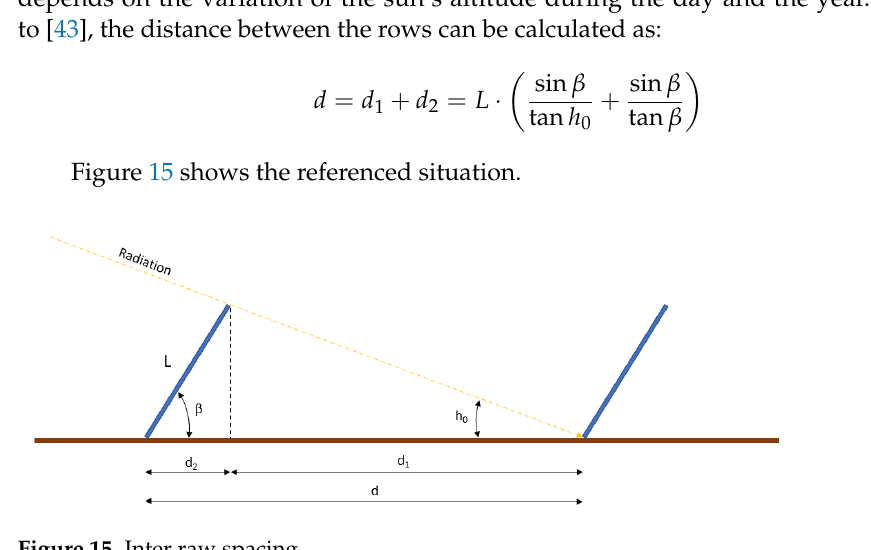
Figure 15. Inter raw spacing.